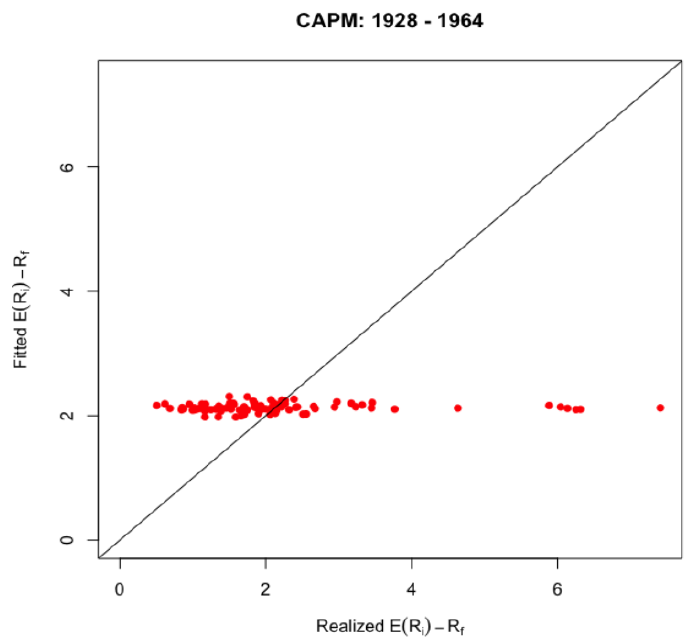
Figure 3. Out-of-sample cross-sectional relationships for the CAPM between average one-month- ahead fitted (predicted) excess returns in percent ( y -axis) and average one-month-ahead realized excess returns in percent ( x -axis): January 1928 to December